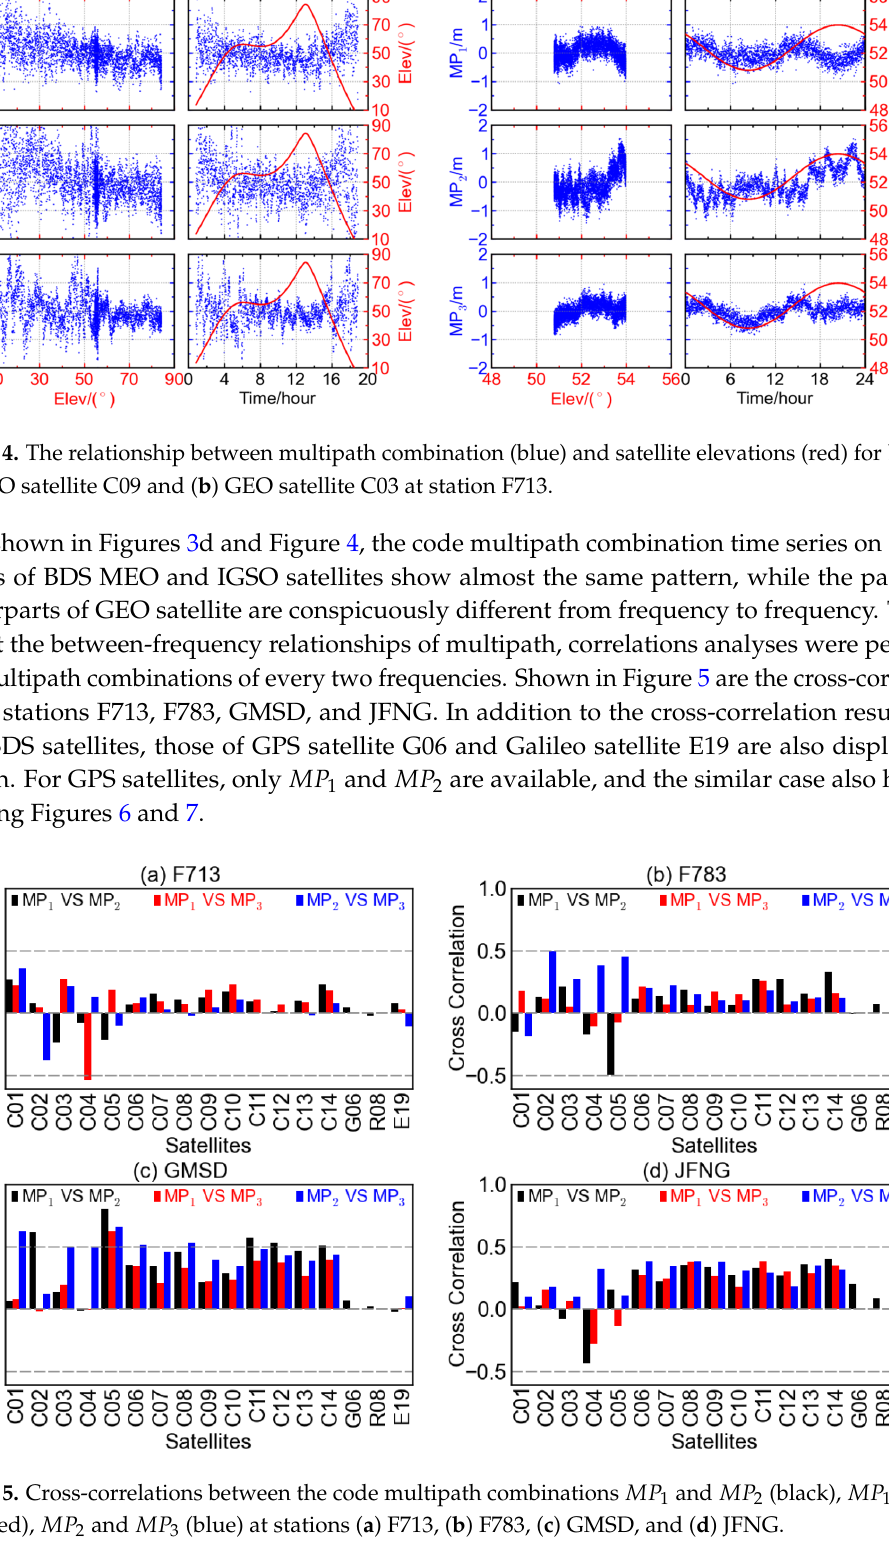
MP and MP (black), 1 2 MP and MP 1 2